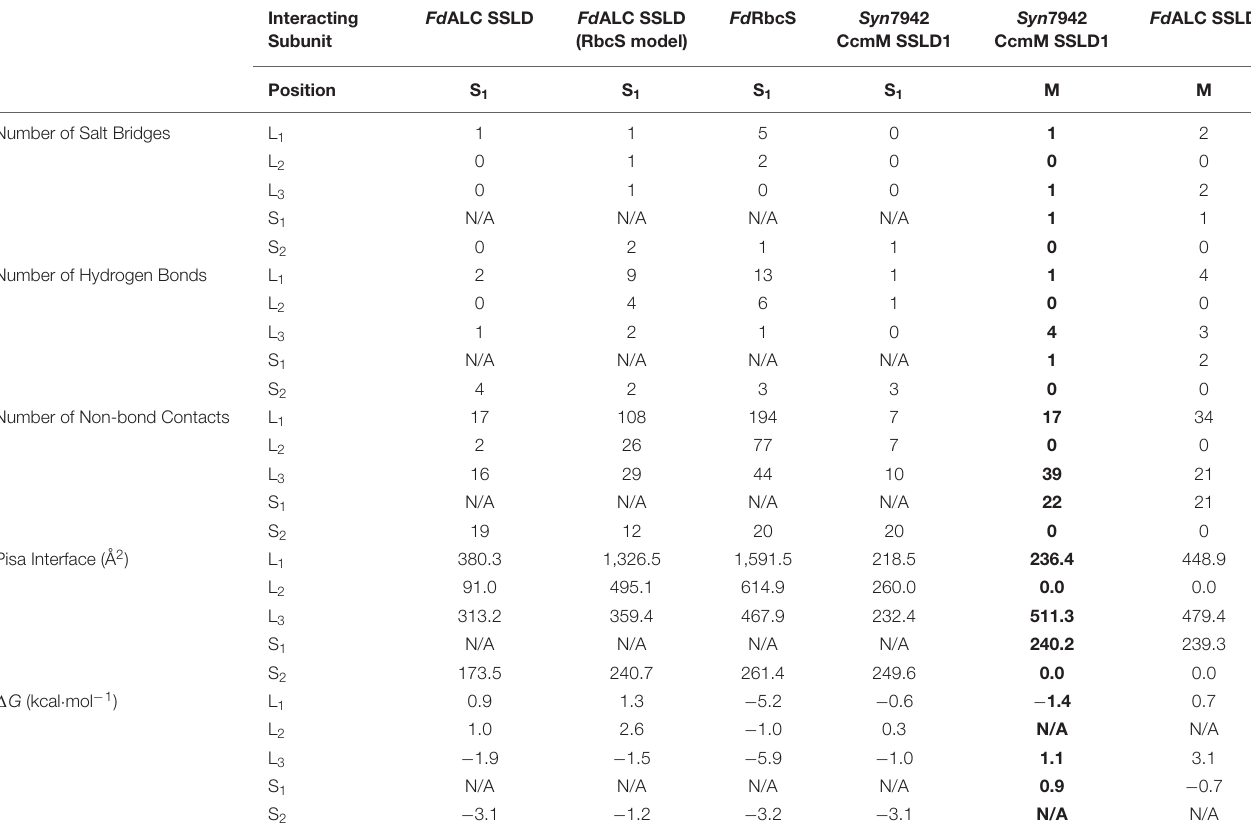
TABLE 1 | Predicted small subunit interactions of rubisco from Fremyella diplosiphon and Synechococcus elongatus PCC 7942. Interacting